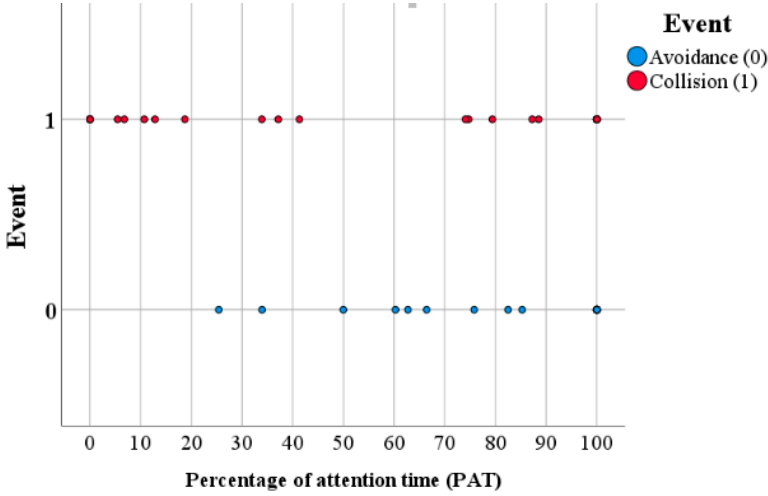
Figure 10. Grouped Scatter of “Event” by “Percentage of attention time”.